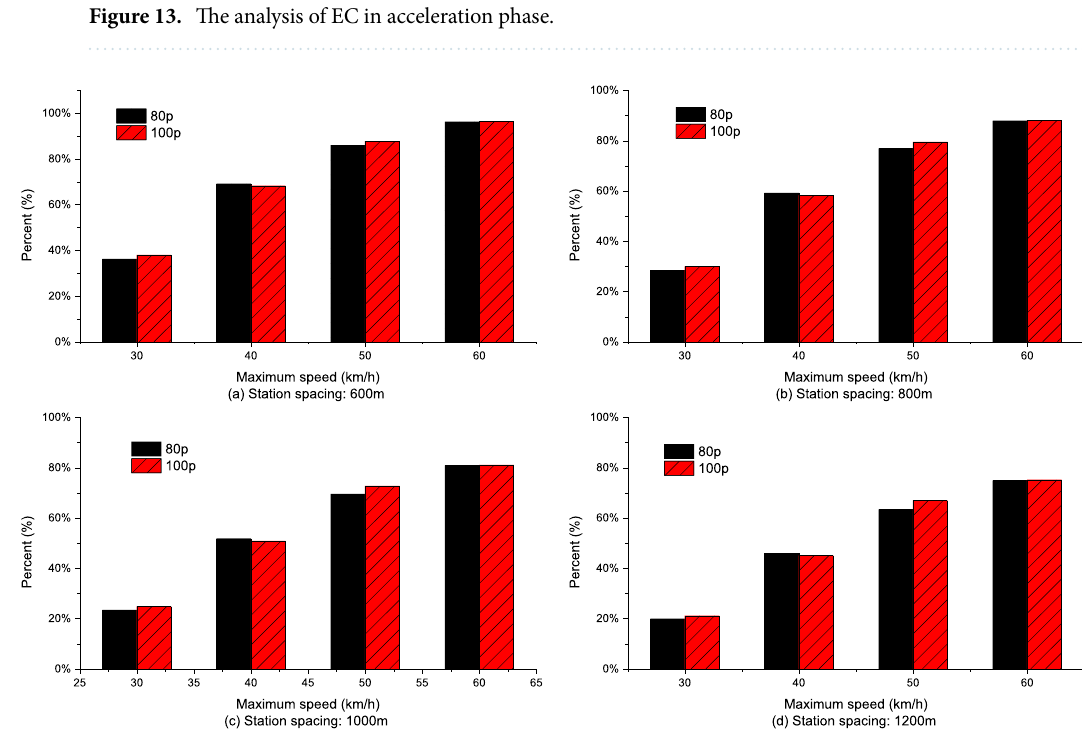
v = 0.4 m/s 2 d t